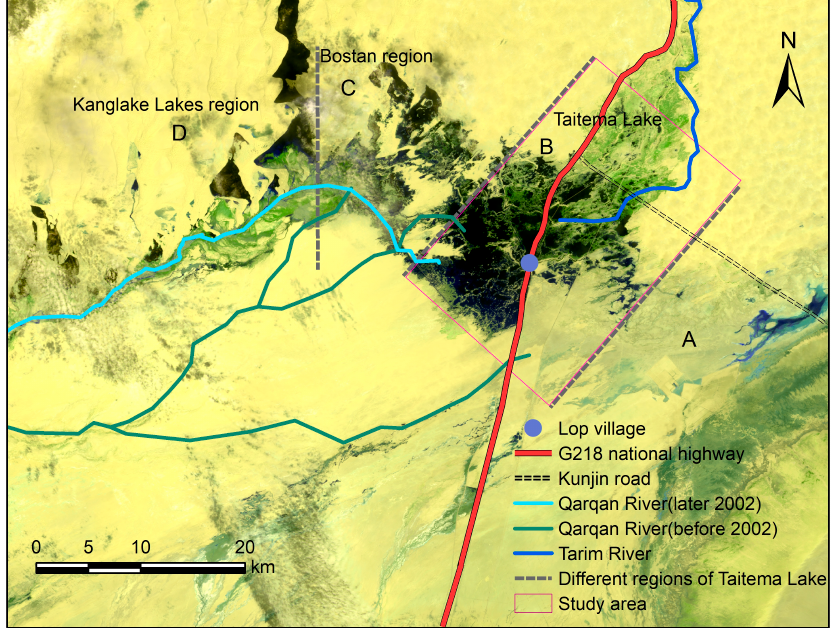
Figure 8. Sketch map of different zones in the study